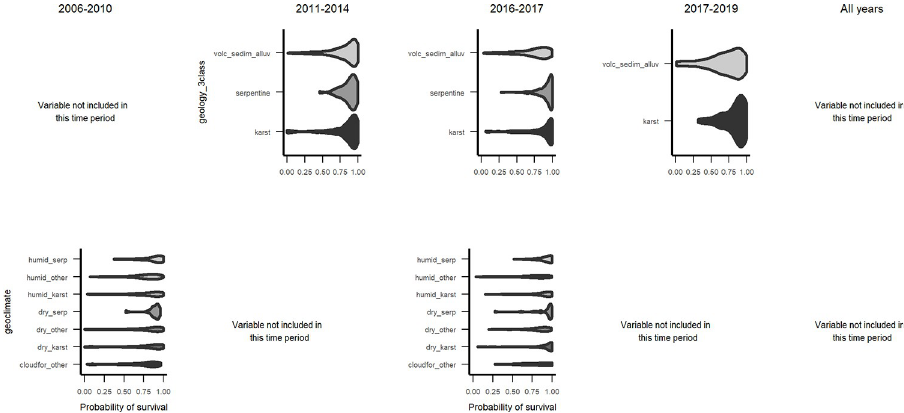
Fig 9. Marginal plots of geological substrate and geoclimate zones through time. Class names are in see Table 3.